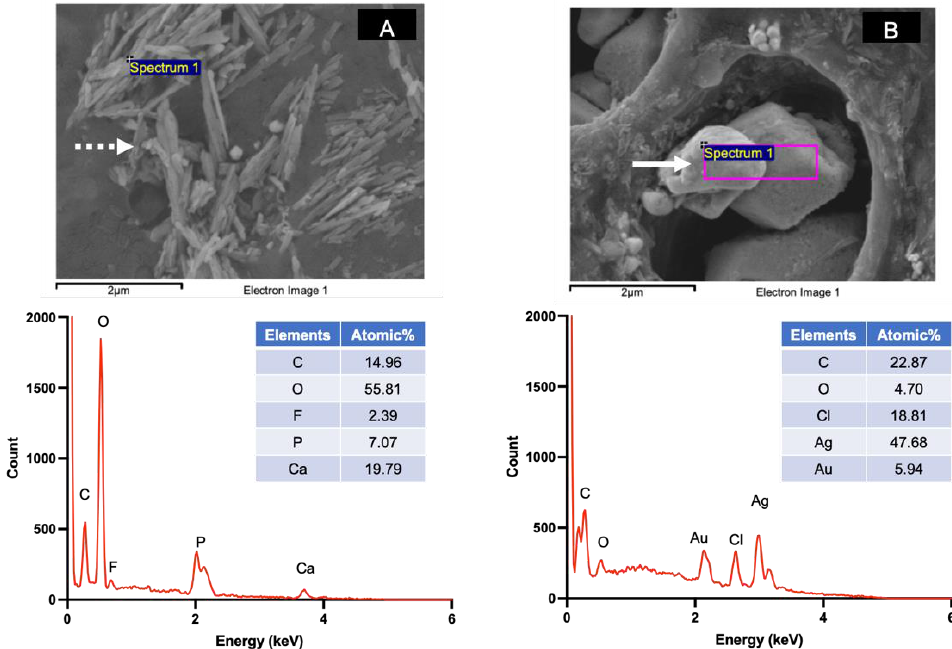
Figure 5. Examples of precipitated crystals and EDX spectra detected on the specimen surface in the 30, 60, and 180 s groups. ( A ) The calcium phosphate precipitate (needle shape, dashed arrow) containing Ca, F, and P. ( B ) Crystals containing Ag and Cl (irregular shape, solid arrow).